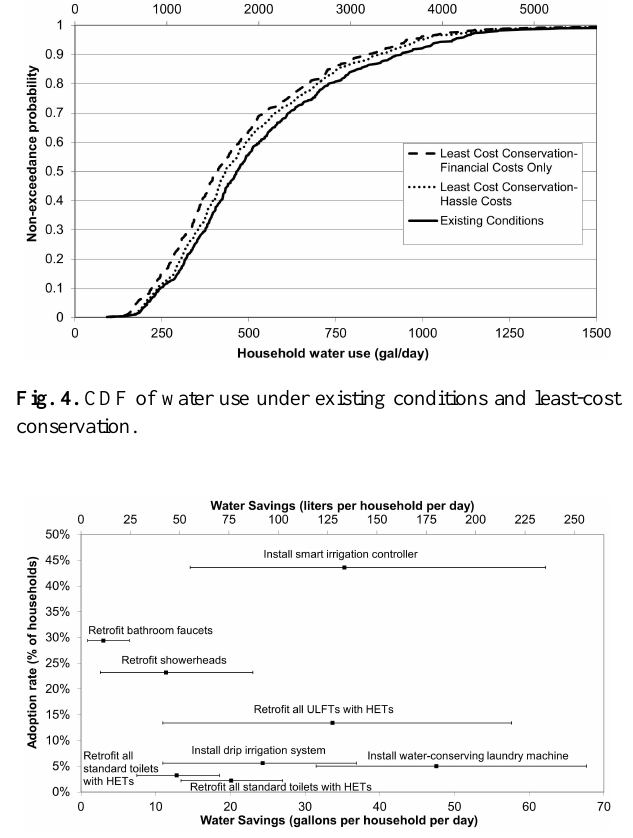
Fig. 5. Modeled market penetration and average water savings for long-term conservation actions, base conditions run with hassle costs (error bars are 10th and 90th percentiles).